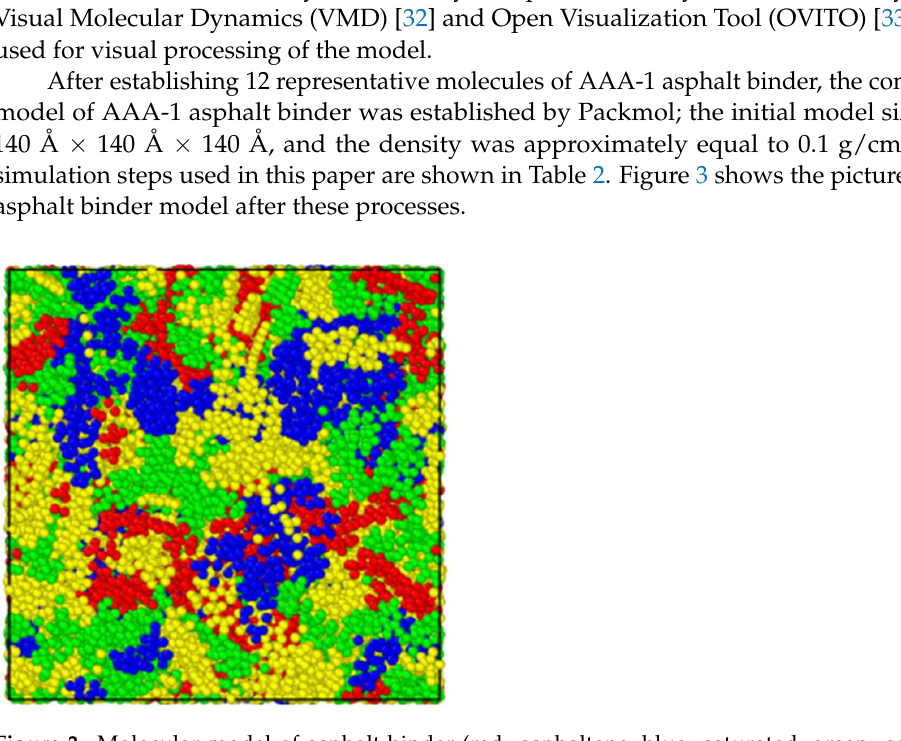
Figure 3. Molecular model of asphalt binder (red: asphaltene, blue: saturated, green: aromatic, yel- low: resin).